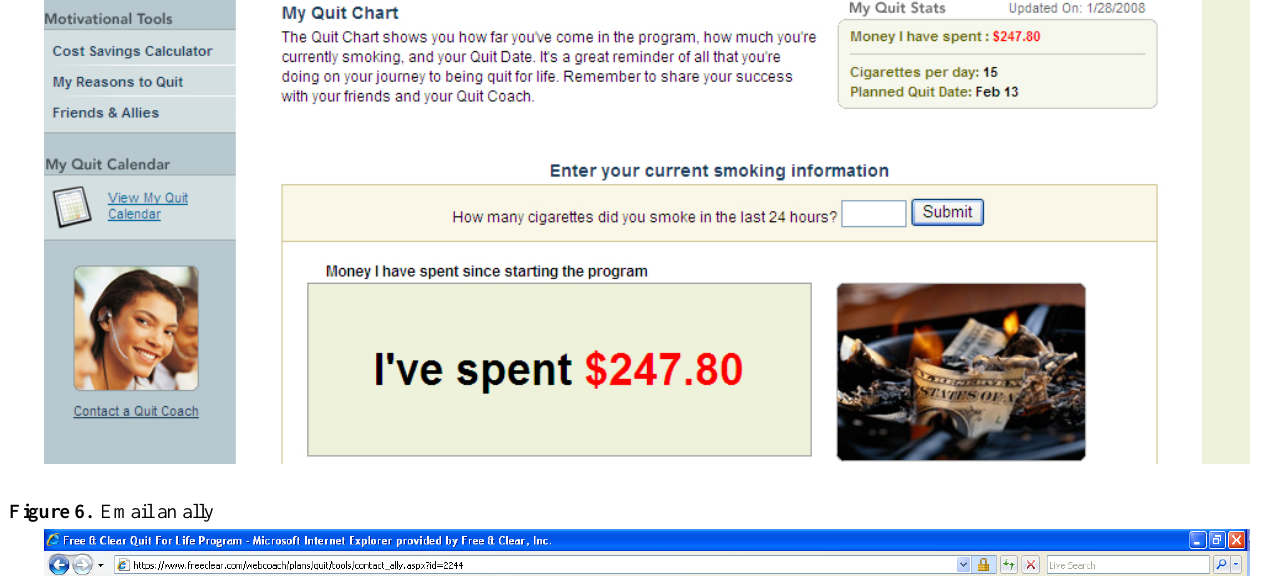
Figure 6. Email an